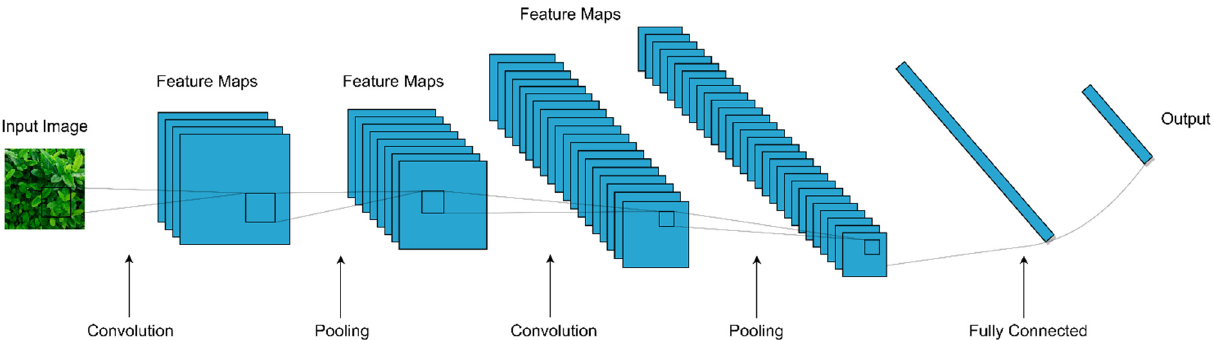
Figure 3. Structure of a typical CNN model.